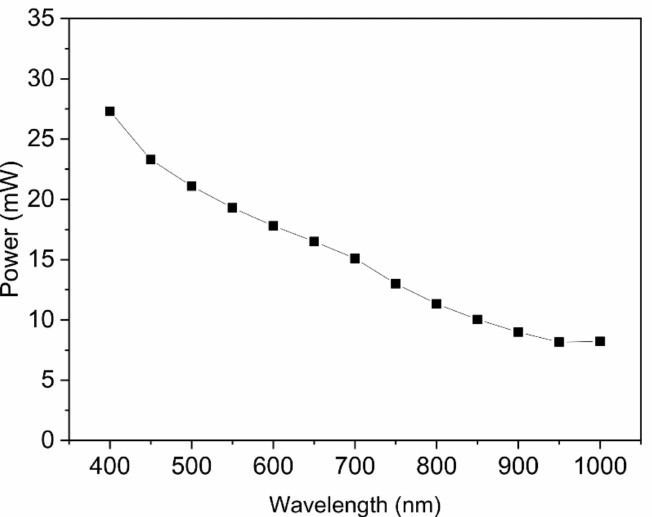
Figure 2. Characteristics of the microscope light between a wavelength of 400 nm and 1000 nm inducing light conditions during the electrical measurements. The Pt/ZnO/Pt cantilevered chip is placed at a distance of 10 cm from the light